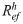
Estimation of Model TMAL in Period 2 (October/2000—September/2004).(a) observed incidence (O) and adjusted i (E), (b) m3/m, (c) Refh (h) and Refm (m), and (d) Ref=Refh×Refm.